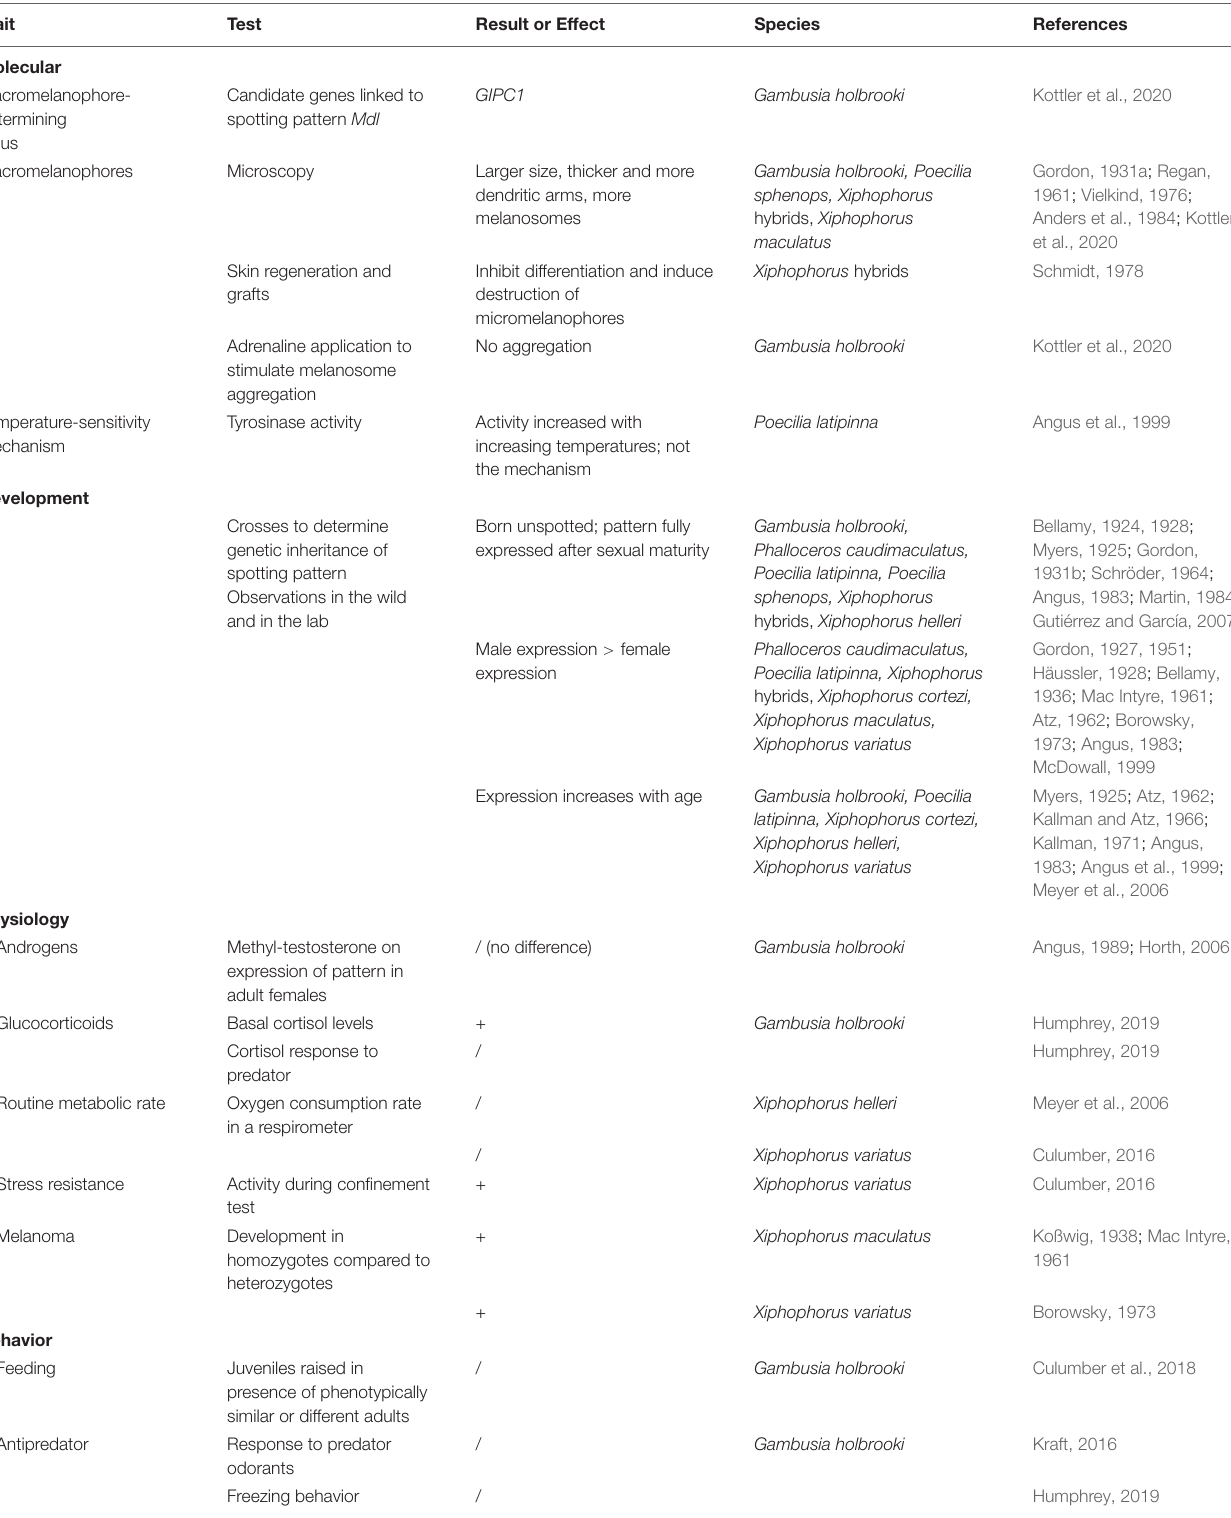
TABLE 2 | Summary of traits and selective pressures investigated for melanic side-spotting pattern in poeciliid species. We briefly describe the experiment and results. Direction of effect is listed as increased (+), decreased ( − ), and no difference (/) for the spotted morph compared to the unspotted morph.